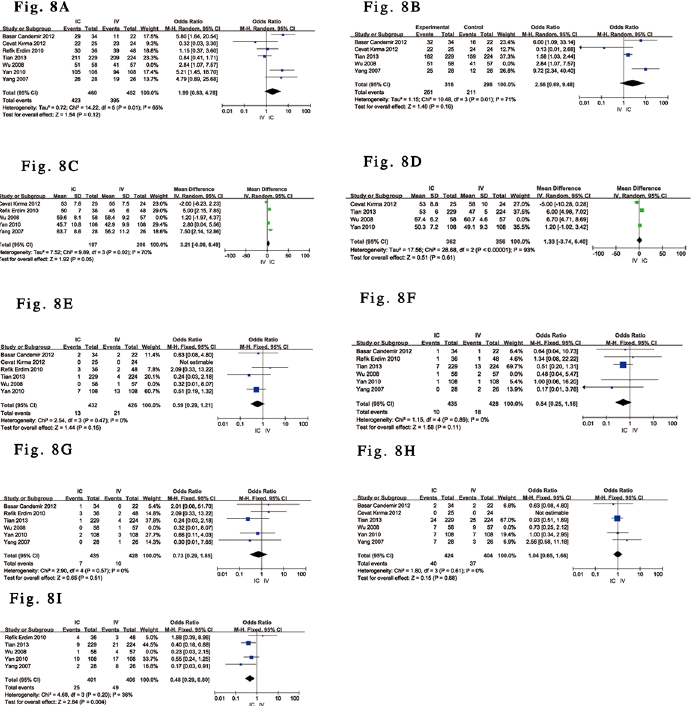
Fig 8. Forest plot for endpoints in STEMI patients treated with IC vs. IV administration of tirofiban. (A). Forest plot for TIMI grade 3 flow based on a random-effects model in STEMI patients treated with IC vs. IV administration of tirofiban. (B). Forest plot for TMP grade 3 based on a random-effects model in STEMI patients treated with IC vs. IV administration of tirofiban. (C). Forest plot for in-hospital LVEF based on a random-effects model in STEMI patients treated with IC vs. IV administration of tirofiban. (D). Forest plot for medium-term LVEF based on a random-effects model in STEMI patients treated with IC vs. IV administration of tirofiban. (E). Forest plot for TVR based on a fixed-effects model in STEMI patients treated with IC vs. IV administration of tirofiban. (F). Forest plot for death based on a fixed-effects model in STEMI patients treated with IC vs. IV administration of tirofiban. (G). Forest plot for reinfarction based on a fixed-effects model in STEMI patients treated with IC vs. IV administration of tirofiban. (H). Forest plot for bleeding events based on a fixed-effects model in STEMI patients treated with IC vs. IV administration of tirofiban. (I). Forest plot for MACE based on fixed-effects model in STEMI patients treated with IC vs. IV administration of